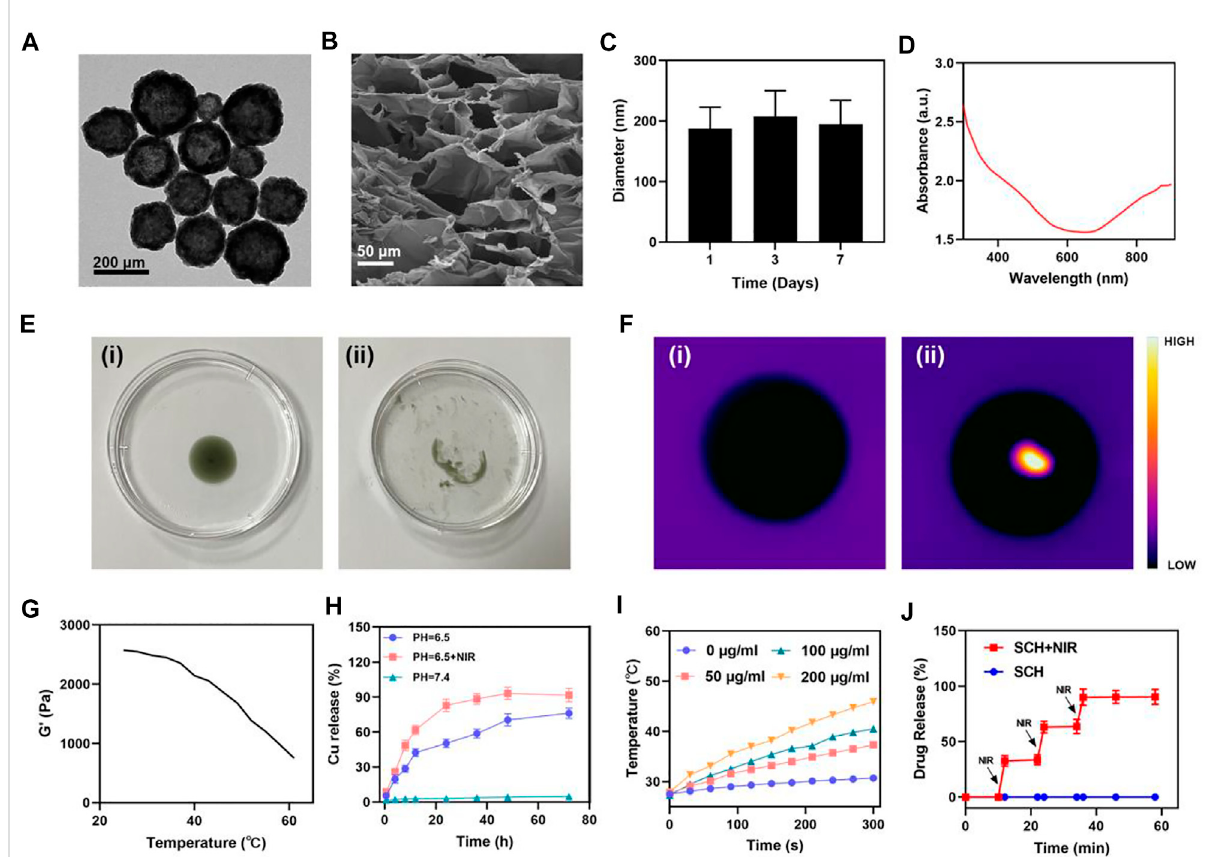
FIGURE 1 CharacterizationofSCH. (A) TEMimageofCuSNPs. (B) SEMimageoftheSCH. (C) TodeterminethehydrodynamicdiameterofCuSNPs(n=3), DLS was employed. (D) CuS NPs absorbance spectra. (E) The morphology and (F) infrared thermal images of the prepared SCH before and after 0.5 W cm − 2 808 nm laser irradiation for 10 min (G) Temperature-dependent Rheological curves for the prepared SCH. (H) Time-dependent Cu 2+ release from the SCH dispersed after different treatments. (I) Temperature changes of CuS NPs at various concentrations under a 5 min irradiation from an 808 nm laser at 0.5 W cm − 2 . (J) Black arrows are utilized to denote the irradiation time points (n = 3) in an in vitro SCH release pro fi le with and without 808 nm laser